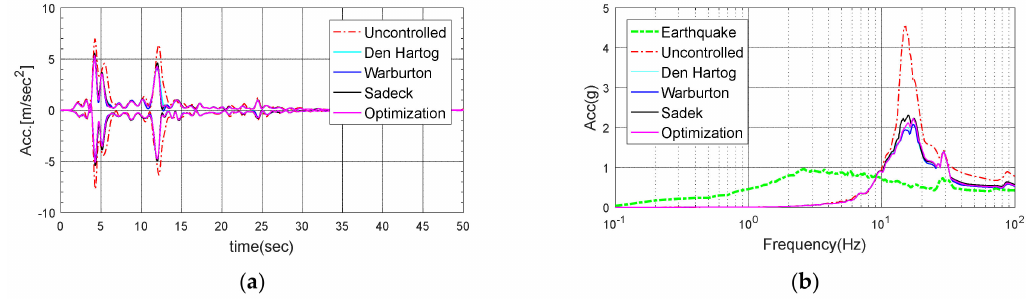
Figure 21. Response of the electrical cabinet subjected to Imperial Valley-2: ( a ) Time history; ( b ) Response spectrum.